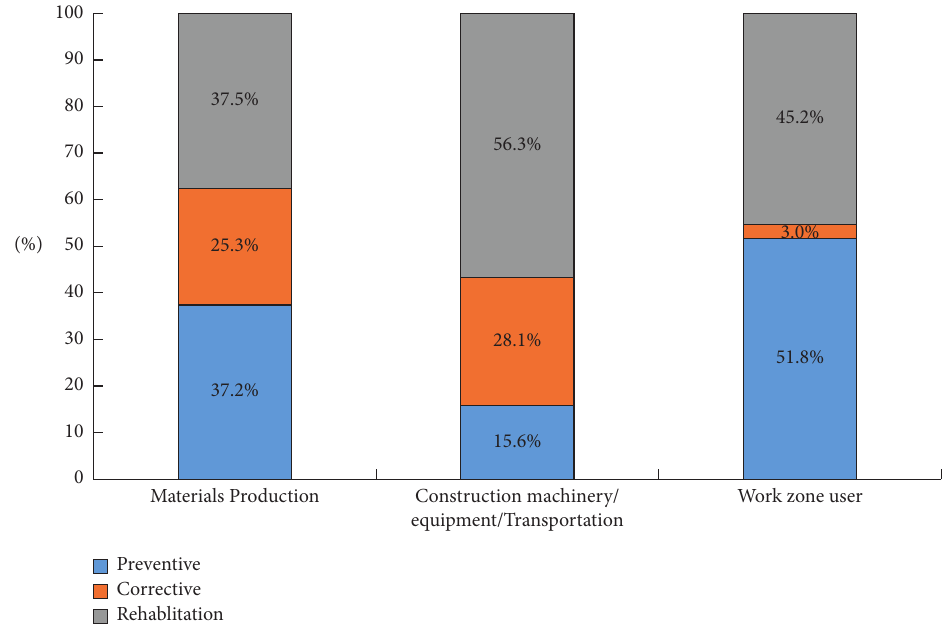
Figure 4: Distribution of CO 2 emissions sources in different types of maintenance event.